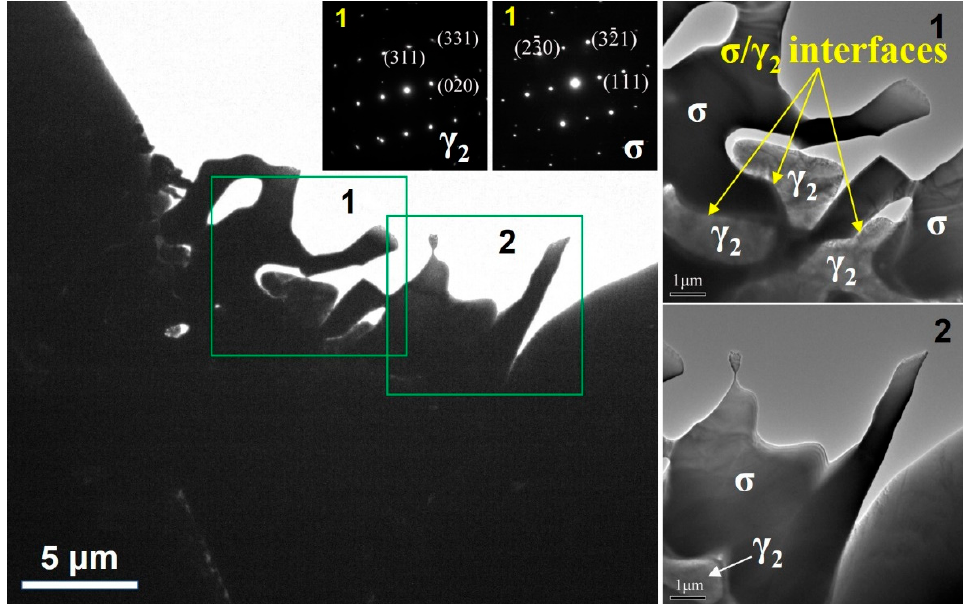
Figure 7. TEM images of the sigma phase in Z3CN20.09M specimens aged at 750 °C for 200 h, with the corresponding selected area electron diffraction patterns in the insets.